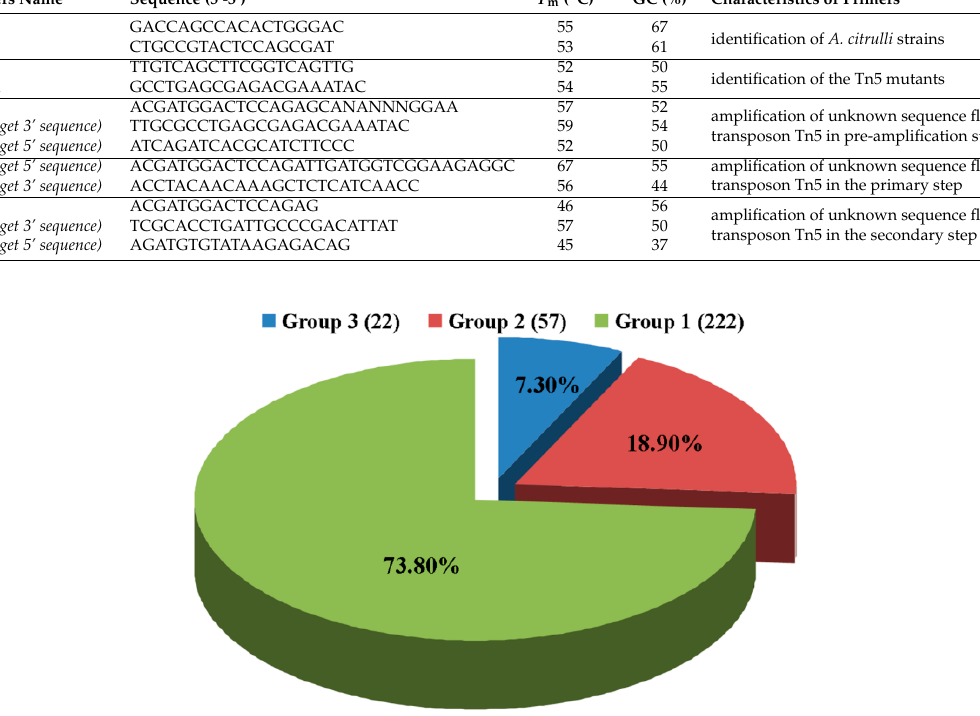
Figure 1. Classification of the Tn5 random insertion mutants based on their virulence to watermelon . Group 1 contains 222 mutants with three, four, and five scales of disease severity; Group 2 contains 57 mutants with two scales of disease severity; Group 3 contains 22 mutants with 0 and 1 scale of disease severity. Disease severity index (5, 4, 3, 2, 1 and 0): lesion area was equal to >90%, 73%–90%, 55%–72%,